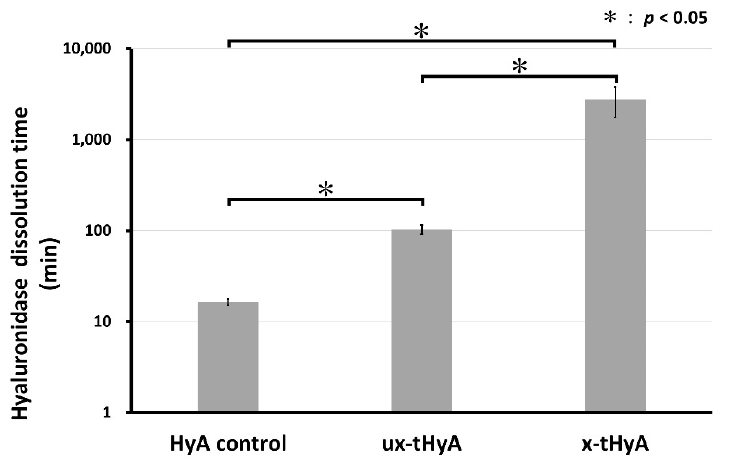
Figure 9. Results of the hyaluronidase dissolution test of three dried HyA samples—HyA control, ux-tHyA, and x-tHyA. Standard deviation error bars were added to graphs. The statistical analysis between two graphs combined by horizontal bar was carried out by Kruskal–Wallis test. *: p <